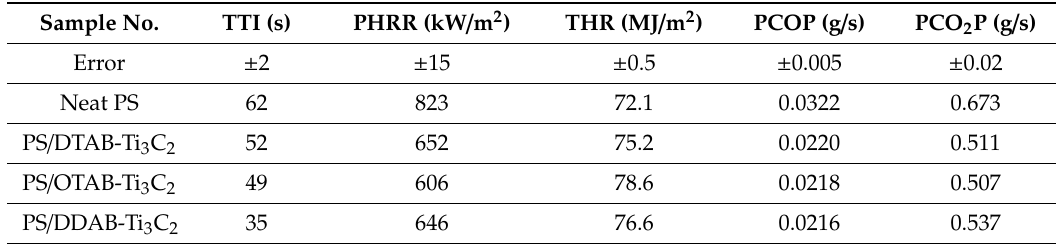
Figure 5. ( a ) HRR, ( b ) total heat release (THR), ( c ) CO and ( d ) CO 2 production curves of PS and its nanocomposites. PHRR = peak heat release rate. Table 2. Cone calorimeter data for each sample at 35 kW / m 2 . (TTI: time to ignition; PHRR: peak heat release rate; THR: total heat release; PCO 2 P: peak CO 2 production; PCOP: peak CO